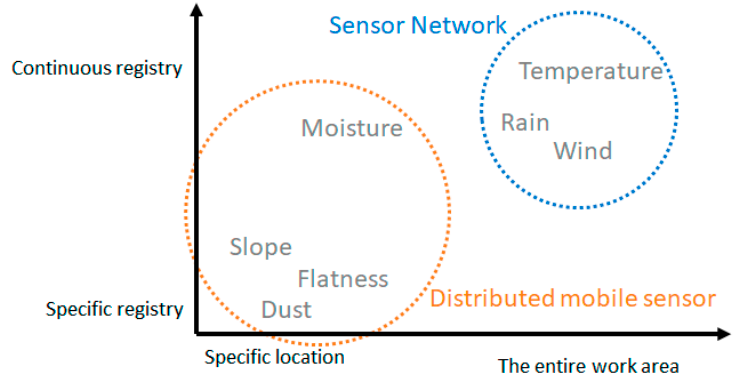
Figure 5. Classification of variables by extension and temporal distribution.